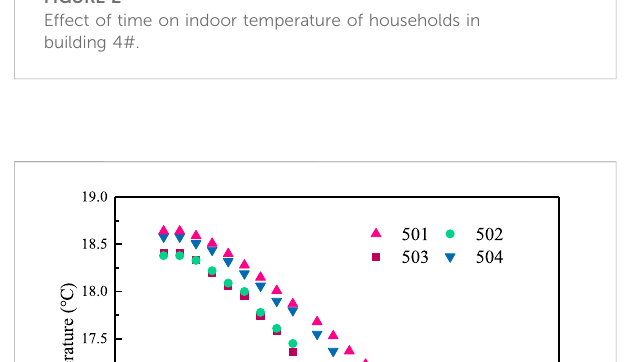
FIGURE 4 Indoor temperatures of households on the 5th fl oor of building 9#.